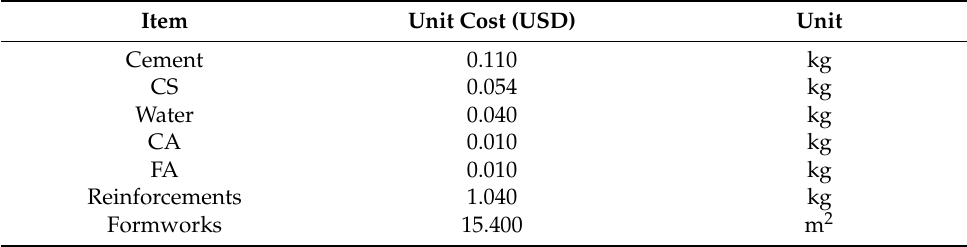
Table 10. Item unit costs in USD, effective for